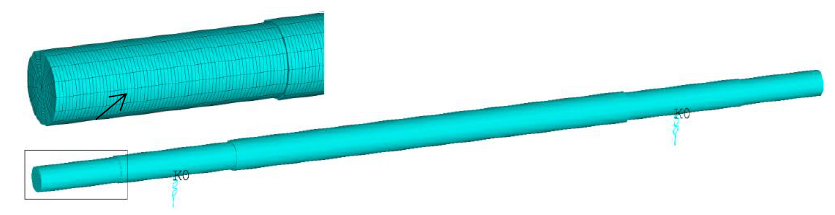
Figure 7. Finite element mesh of the rotordynamics model.